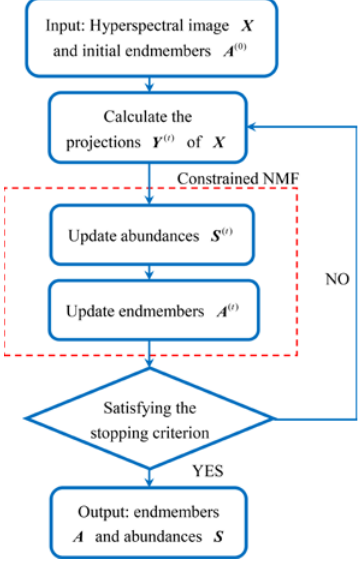
Figure 7. Flowchart of the proposed method.